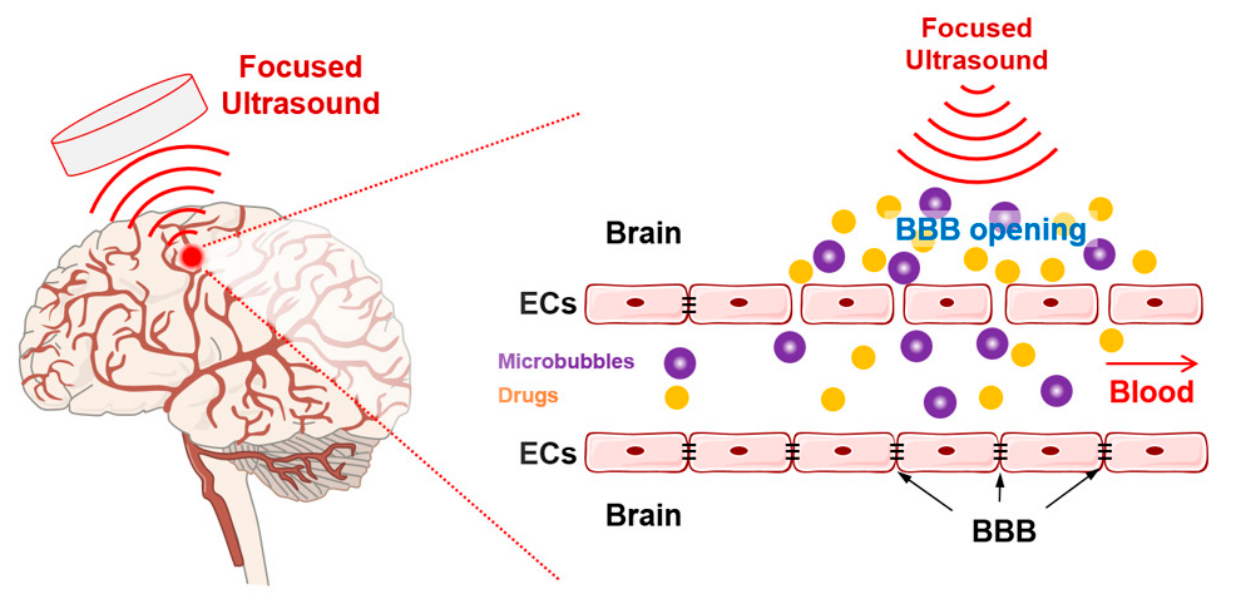
Figure 5. Conceptual schematic representation of therapeutic effects of focused ultrasound. Focused ultrasound induces the opening of the blood–brain barrier through microbubble generation, and it can be coupled with microbubble injection and drug delivery for improved efficacy.